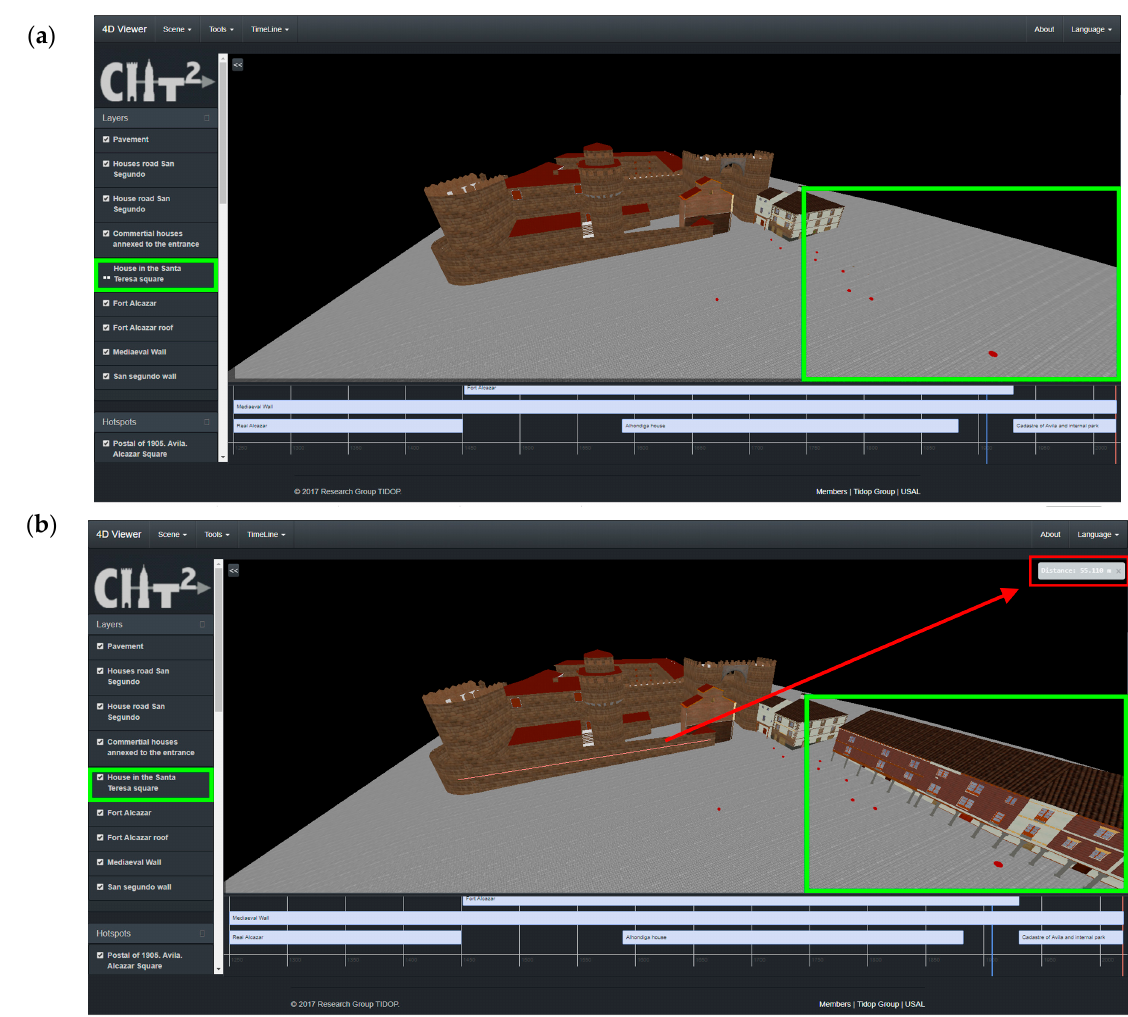
Figure 14. Screenshots of the application on which it is possible to observe the asynchronous loading scheme used: ( a ) previously to the loading of the model called “House in the Santa Teresa Square” and; ( b ) after the loading of all the models. The capacity of taking measurements on the different 3D models is highlighted in red.